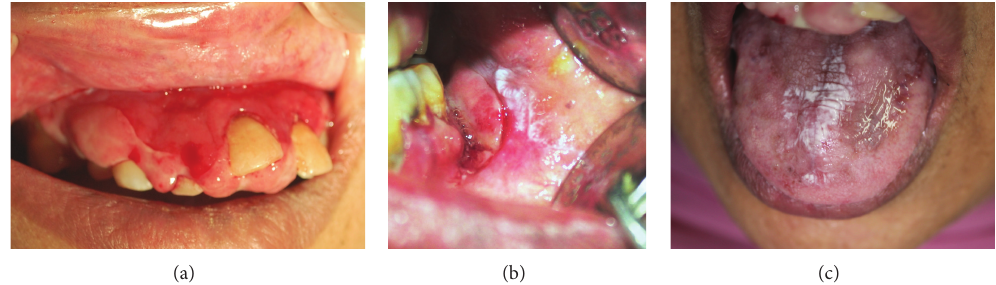
Figure 2: (a) shows generalized erythema and fragility with very fine white striae at the tips of interdental papillae. (b) shows dense white striae (plaque type LP) bordering erythematous lesions on buccal mucosa. (c) shows white plaque type patch with loss of papilla and melanin pigmentation on the dorsum of